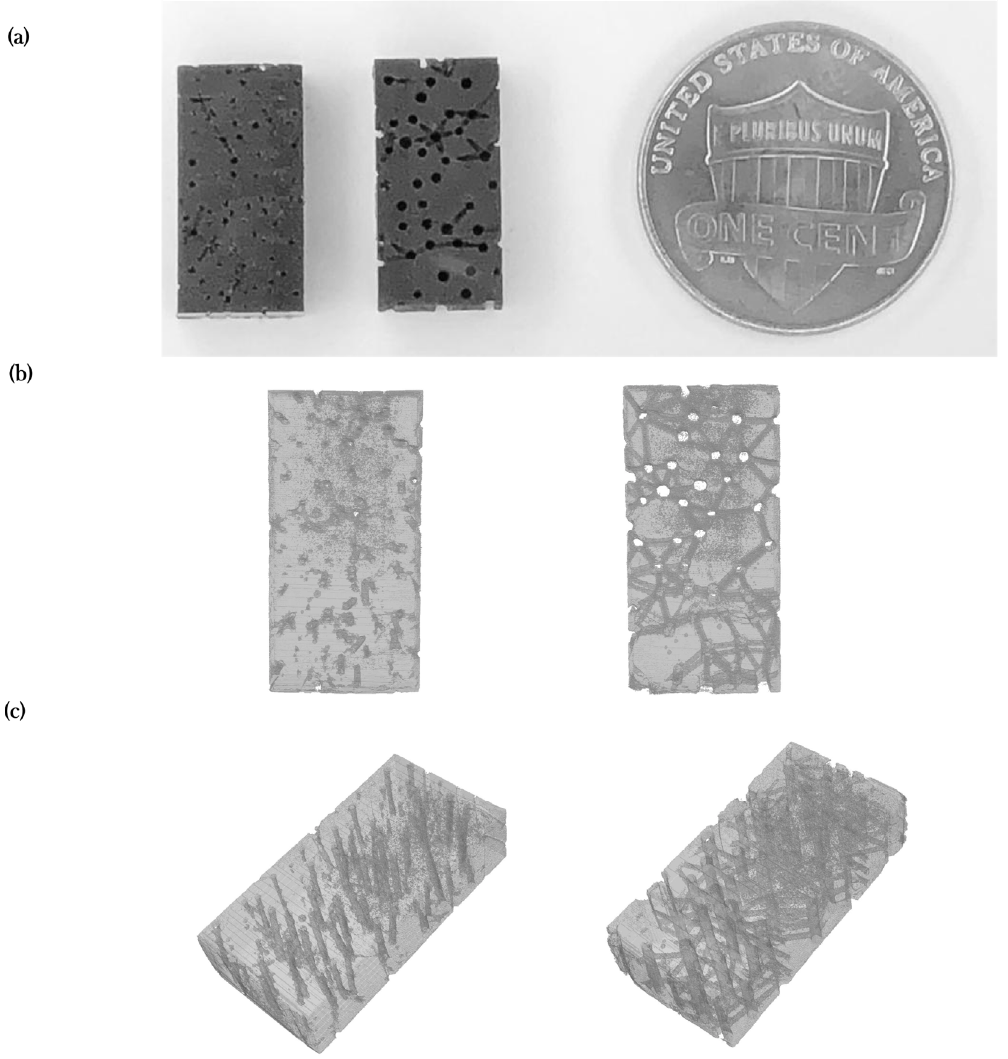
Figure 5. Additive manufacturing assessment; ( a ) Photos of the specimens manufactured using DLP for the scaled up versions of Model I ( left ) and Model III ( right ); ( b ) MicroCT reconstructions (top view) of the scaled up versions of Model I ( left ) and Model III ( right ); ( c ) MicroCT reconstructions (isometric view) of the scaled up versions of Model I ( left ) and Model III ( right ).